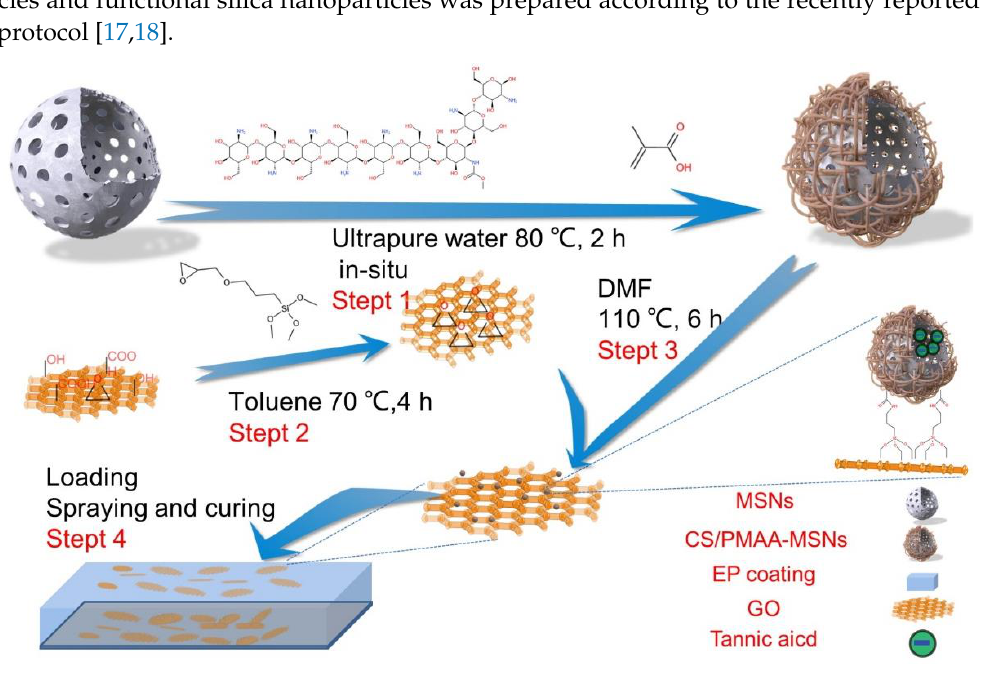
Figure 1. Schematic route of the smart anticorrosive epoxy coating based on graphene ox- ide/functional mesoporous silica